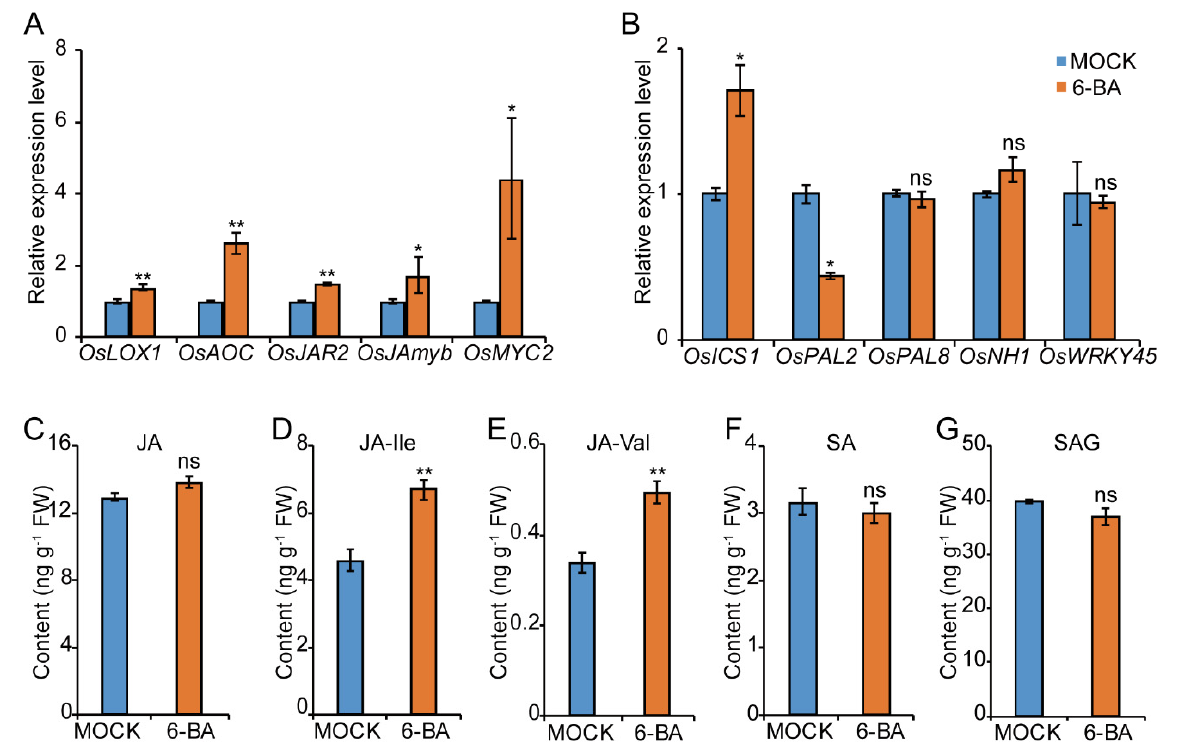
Figure 4. CK promotes the JA pathway in response to BPH in rice. ( A ) Transcript levels of JA-pathway-related genes in rice sheaths pretreated with 0.1 µM 6-BA or mock treatment post infestation with BPH for 24 h, respectively. The expression levels of mock-treated plants were set as 1. Ubiquitin was used as an internal reference. ( C – E ) Contents of JA and conjugates of JA in rice sheaths pretreated with 0.1 µM 6-BA or mock treatment, respectively, and infested with BPH for 24 h. JA-Ile, Jasmonoyl-L-isoleucine; JA-Val, N-[(-)-Jasmonoyl]-(L)-valine. ( B ) Transcript levels of SA-pathway-related genes in rice sheaths pretreated with 6-BA or mock treatment at 24 h post infestation with BPH, respectively. ( F , G ) Contents of SA and salicylic acid 2-O- β -Glucoside (SAG) in rice sheaths pretreated with 6-BA or mock treatment at 24 h post infestation with BPH, respectively. FW, fresh weight. Values are means ± SD, n = 3. Statistical significances were determined by two-tailed Student’s t -test, * p < 0.05, ** p < 0.01, ns, no significant difference.